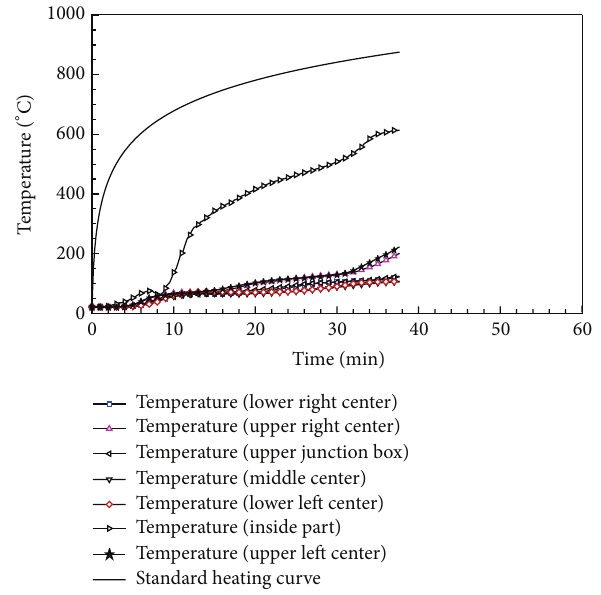
Figure 11: Time-temperature chart for the specimen in Test